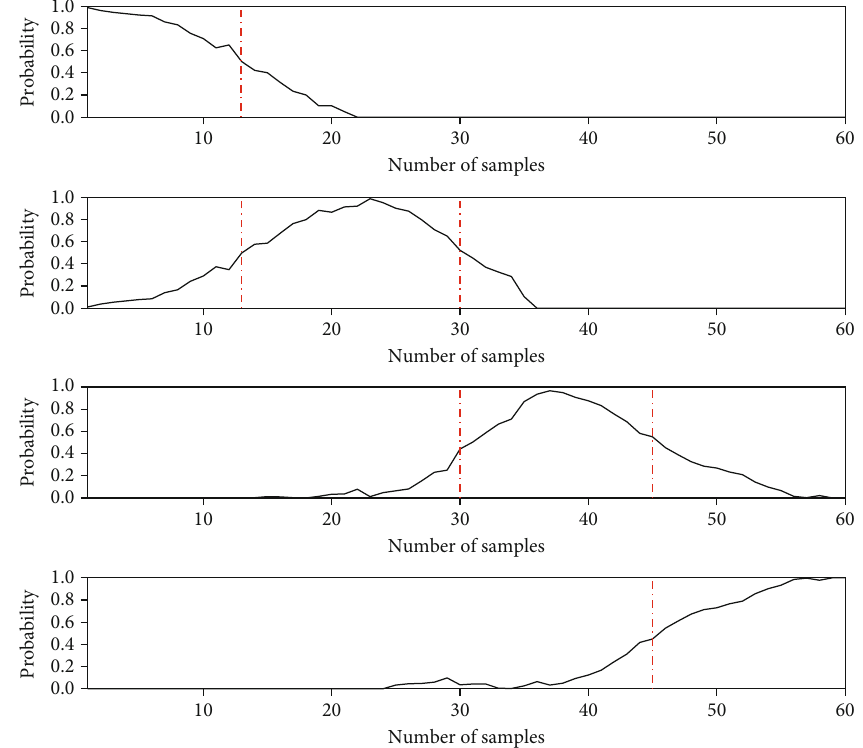
Figure 7: The probability of each state degree.